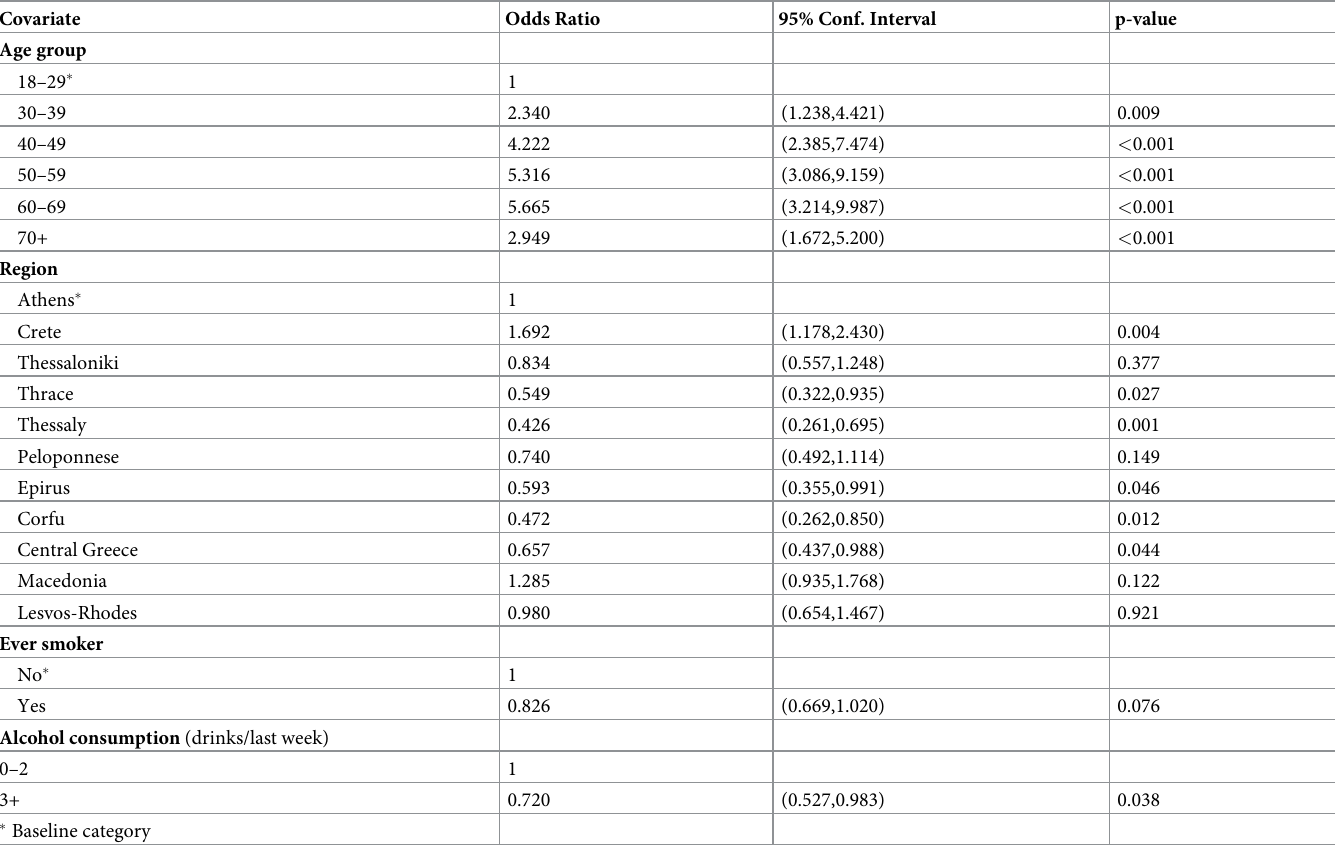
Table 3. Results from weighted logistic regression analysis to assess the factors independently related to thyroid disease in women. Covariate Odds Ratio 95% Conf. Interval